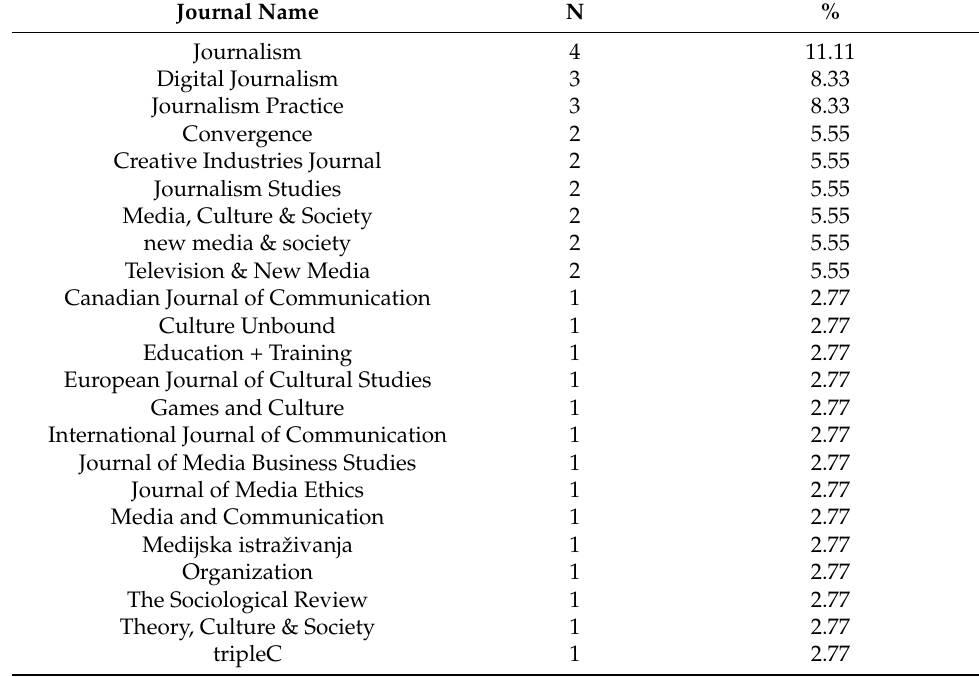
Table 3. Distribution of the papers based on the name of